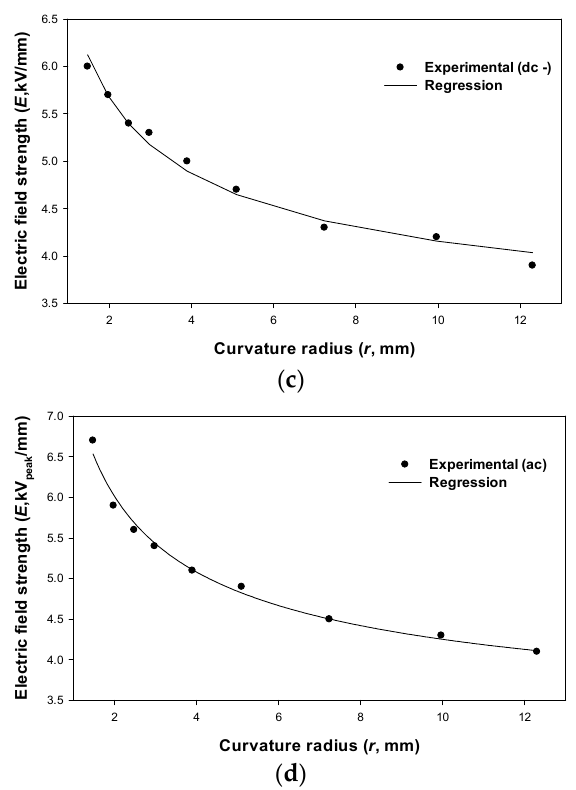
Figure 7. ( a ) Surface electric field strength versus the curvature radius of the sphere under corona extinction conditions for positive dc, negative dc and ac supply; ( b ) Peak curve regression for positive dc conditions; ( c ) Peak curve regression for negative dc conditions; ( d ) Peak curve regression for ac conditions.